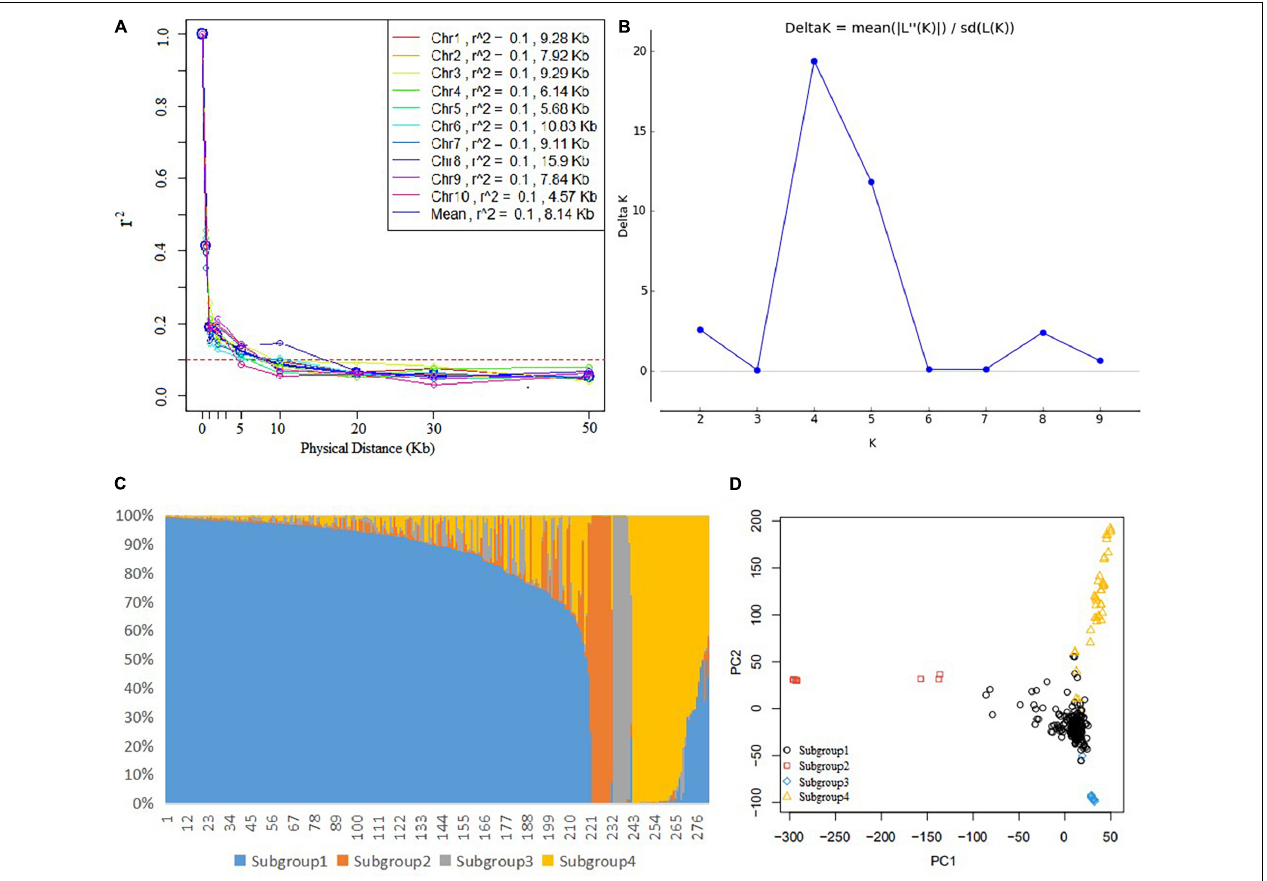
FIGURE 1 | Analysis of genetic diversity in the genome-wide association study (GWAS) panel. (A) Linkage disequilibrium decay across all 10 maize chromosomes, (B) the plot of delta K , (C) the estimated probability membership for each inbred line at K = 4, and (D) the principal component analysis plot showing four subgroups corresponding to the four subgroups by the STRUCTURE